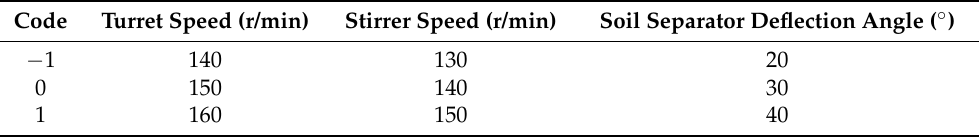
Table 3. Table of factor levels of the interaction